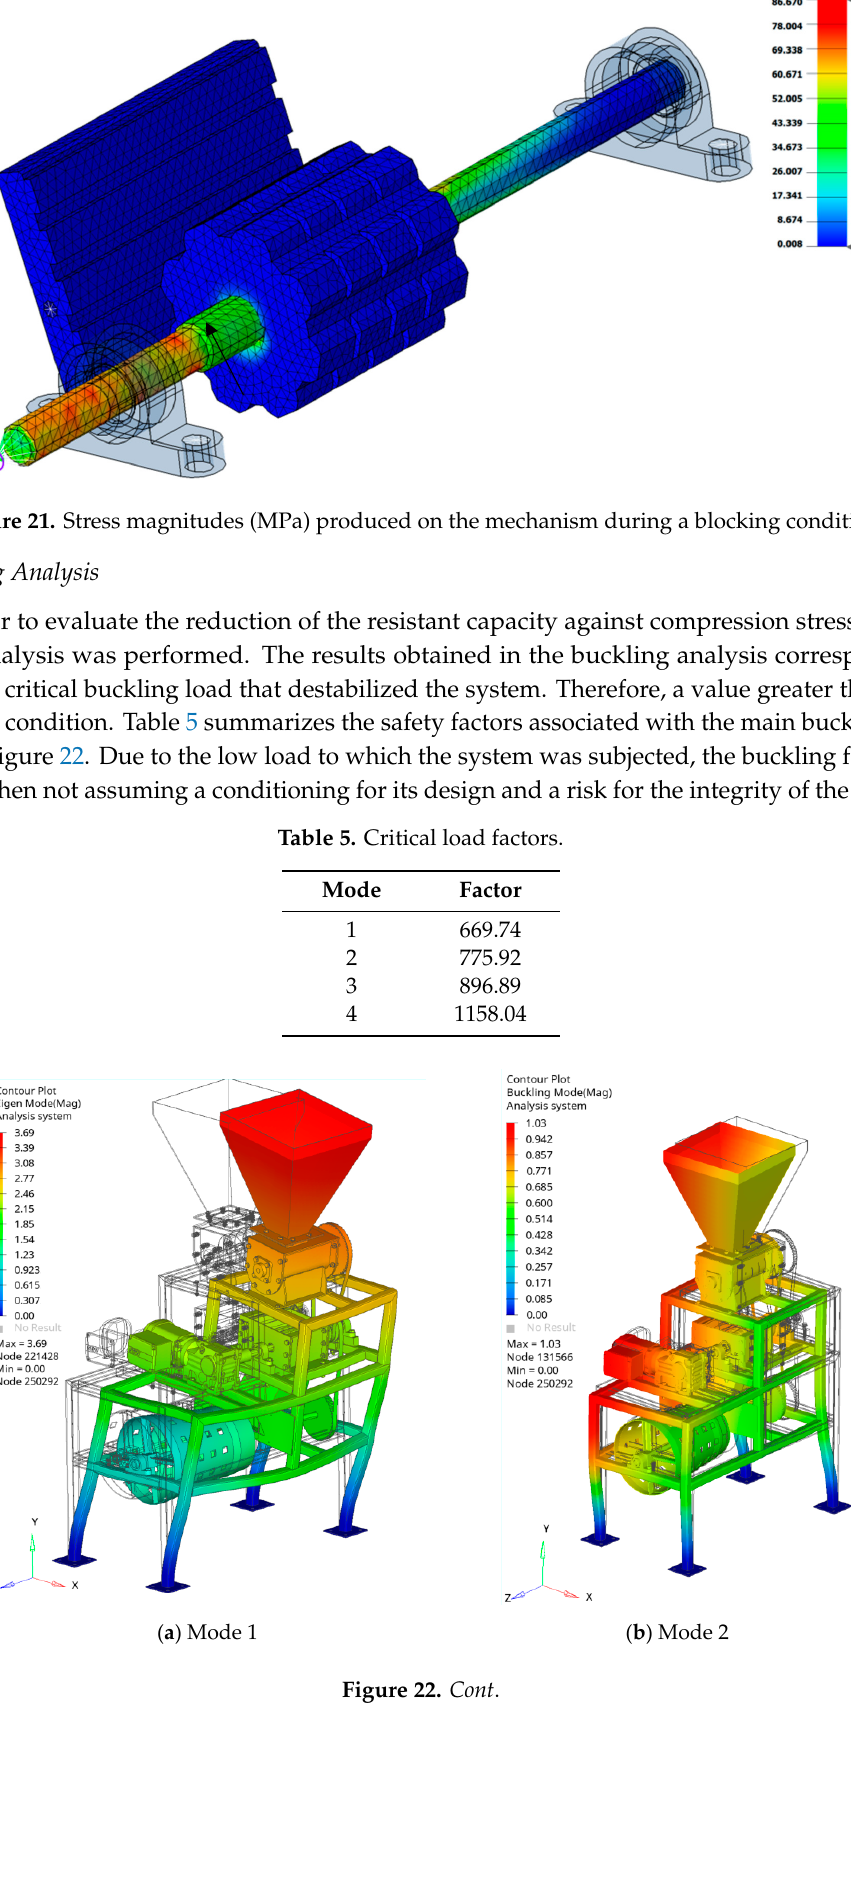
19 of 25 Figure 20. ( a ) Von Misses stresses contour (MPa) in static load case; ( b ) resultant displacements (mm) in static load case, scaled 500×. A second static analysis was carried out according to the worst possible situation in the machine during its operation. This situation corresponded to the blocking of the fracture mechanism if Metohuayo fruits could not be cracked. When this situation occurred, the electric motor transmitted